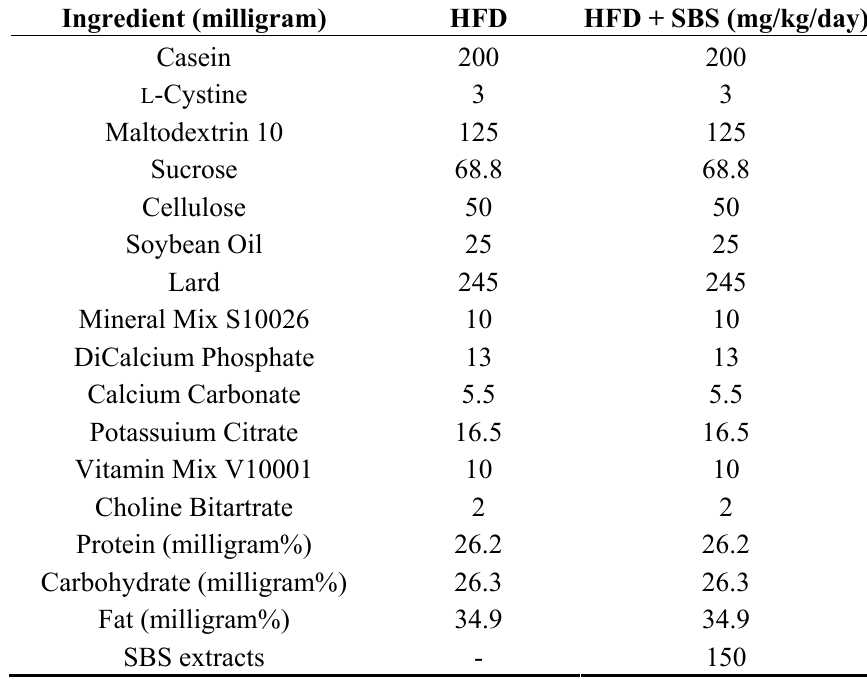
Table 1. Ingredient composition of the experimental